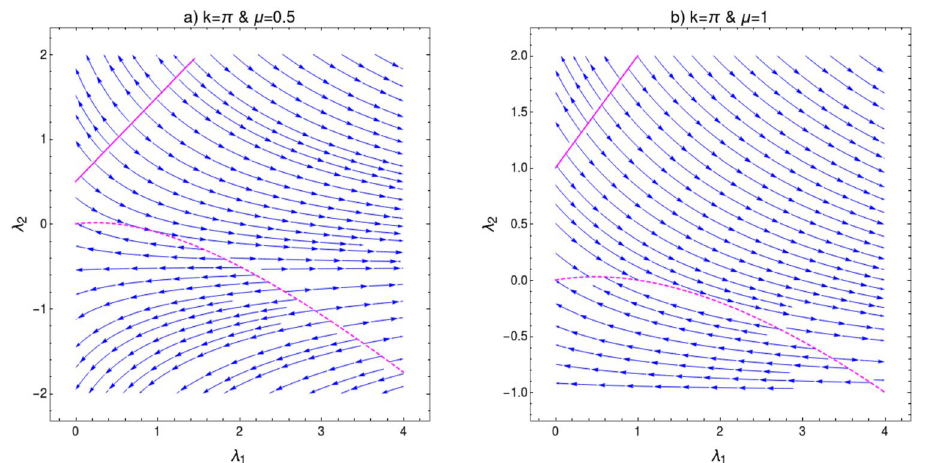
Figure 7. The behavior of the curvature function around the HSP k 0 around the critical value (cid:31) 1 behavior to perform CRG as it diverges at HSP on approaching critical point.